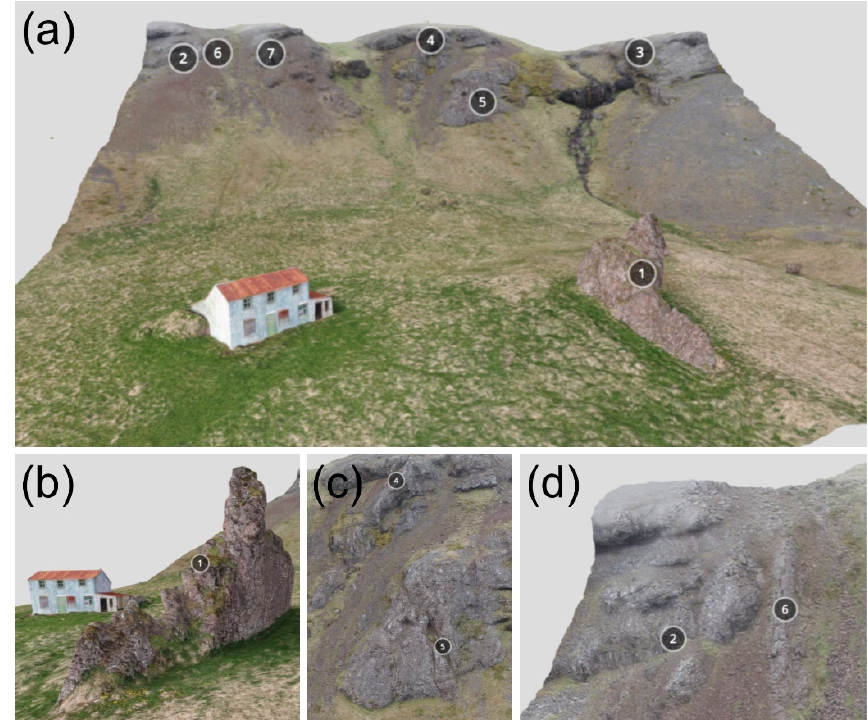
Figure 11. ( a ) Overall view of the 3D model. Numbers are interactive annotations that can be clicked online, providing the viewer with explanations about particularly relevant features; ( b ) detail of the towering dyke (house for scale); ( c ) focus on the inclined sheet (annotation 4) and the subvertical dyke (annotation 5); ( d ) the lava succession that represents the host rock, within which all the subvolcanic bodies have been emplaced (annotation 2), cut by a vertical dyke (annotation 6).